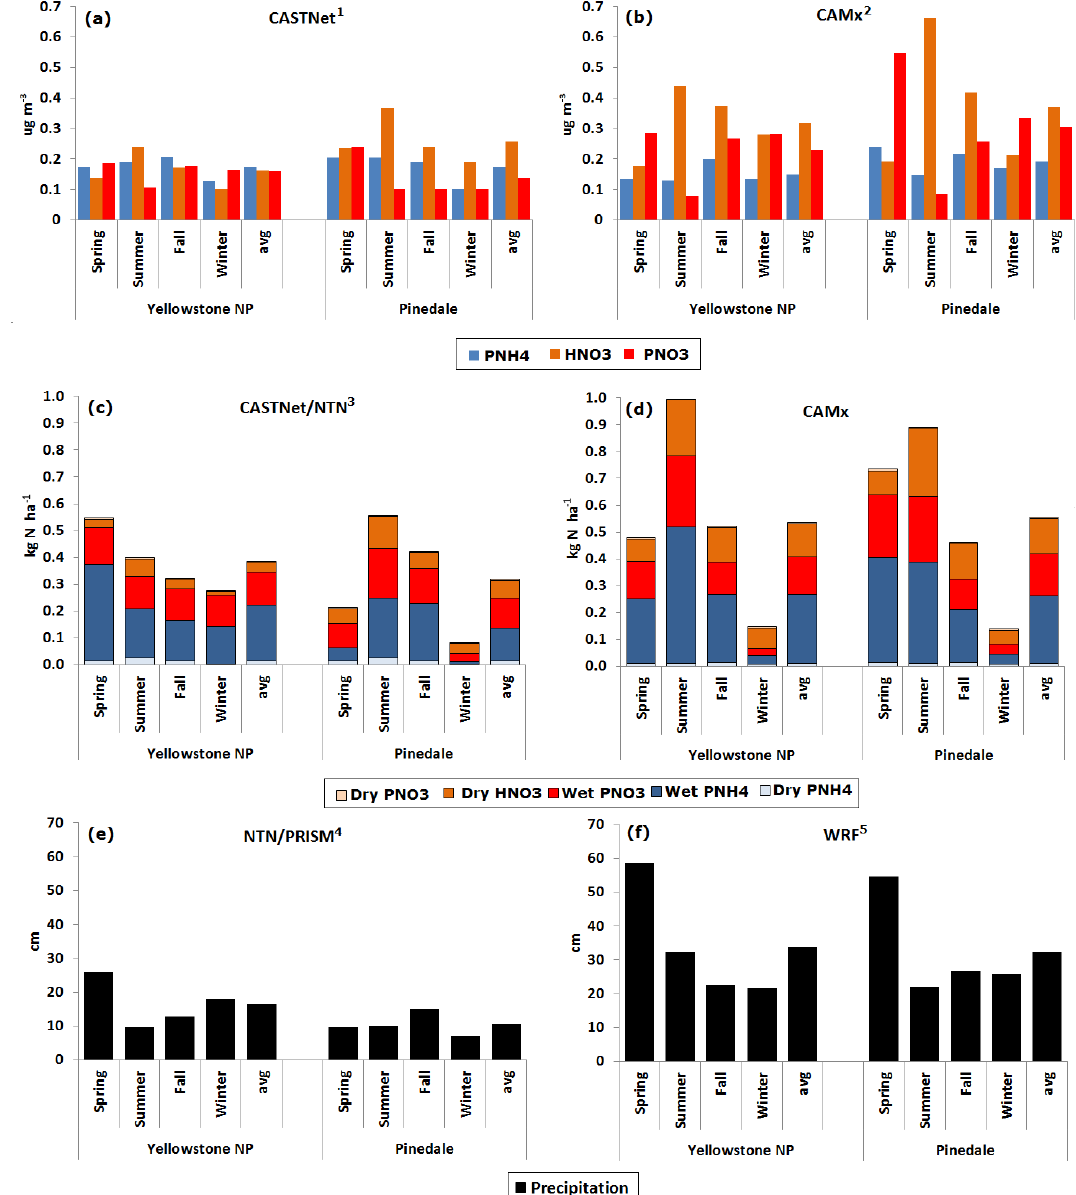
Figure 3. Model performance for (a, b) seasonal average N r concentration, (c, d) seasonal accumulated N r deposition budget, and (e, f) sea- sonal accumulated precipitation amount at collocated location sites (YNP and Pinedale) over the GYA in 2011. 1 Clean Air Status and Trends Network. 2 Comprehensive Air Quality Model with extensions. 3 National Trends Network. 4 Parameter-elevation Regressions on Independent Slopes Model. 5 Weather Research and Forecasting